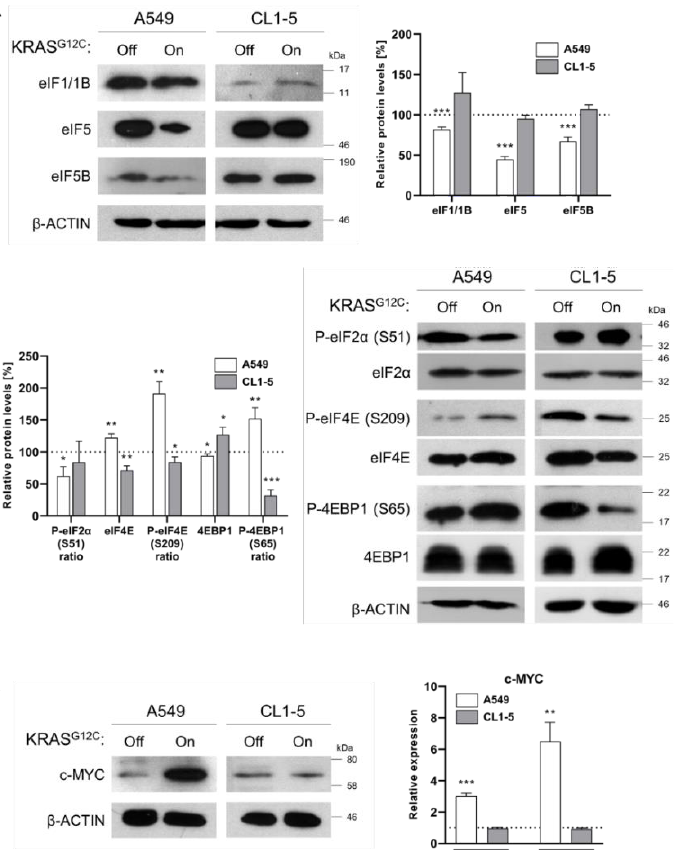
Figure 3. KRAS G12C affects translation fidelity during mRNA scanning and cap-dependent transla- tion initiation. ( A ) Immunoblot analysis of key translation initiation factors involved in the stringency of start codon selection during mRNA scanning in A549 and CL1-5 cells before (Off) and after (On) KRAS G12C short-term induction with doxycycline. The protein levels were normalized against β -actin levels in each separate set of experiments. Band intensities are shown as a percentage (%) of relative protein levels as compared to the control (dotted line). ( B ) Immunoblot analysis of key translation initiation factors that regulate global translation rates in A549 and CL1-5 cells before (Off) and after (On) KRAS G12C short-term induction with doxycycline. The protein levels were normalized against β -actin levels in each separate set of experiments. Band intensities are shown as a percentage (%) of relative protein levels as compared to the control (dotted line). Phos- phorylation levels are shown as a ratio of phosphorylated to total relative protein levels. ( C ) Im- munoblot analysis of c-MYC in A549 and CL1-5 cells before (Off) and after (On) KRAS G12C short- term induction with doxycycline. mRNA levels were identified by RT-qPCR and the relative pro- tein levels were calculated after normalization against β -actin levels. Relative levels are shown as compared to the control (dotted line). Data are compared by using unpaired Student’s t -test and are presented as means ± SD of biological triplicates. P -values are indicated with * p < 0.05; ** p < 0.01; *** p < 0.001.